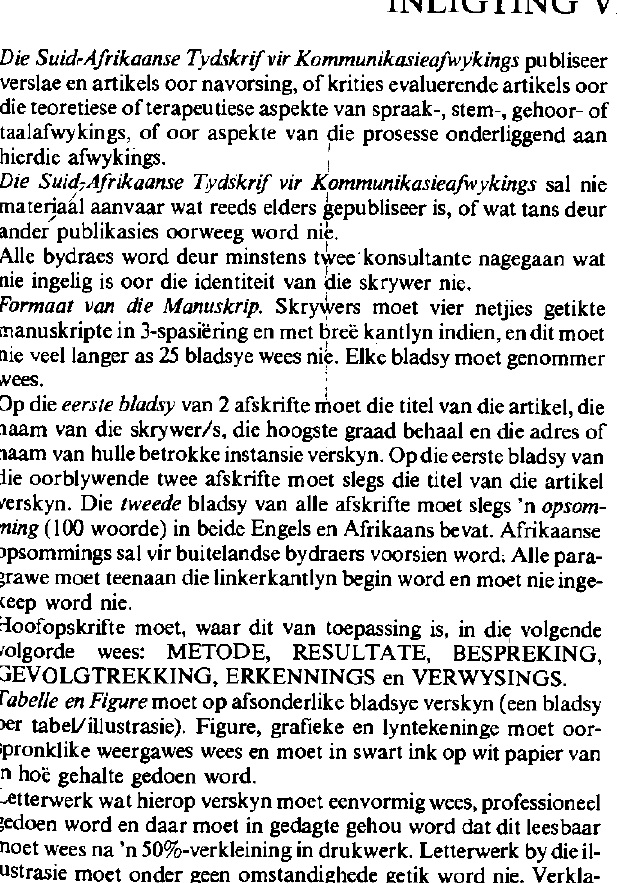
Tabelle en Figure moet op afsonderlike bladsye verskyn (een bladsy per tabel/illustrasie). Figure, grafieke en lyntekeninge moet oor- spronklike weergawes wees en moet in swart ink op wit papier van 'n hoe gehalte gedoen word.